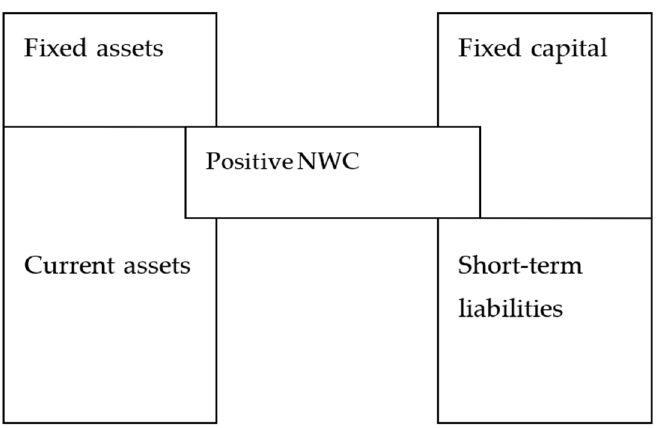
Figure 3. Positive net working capital. Source: own research.